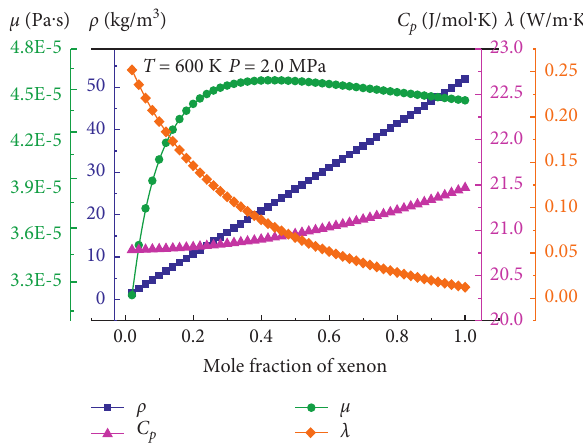
Figure 4: Variation of properties for helium-xenon mixtures with mole fraction of xenon.